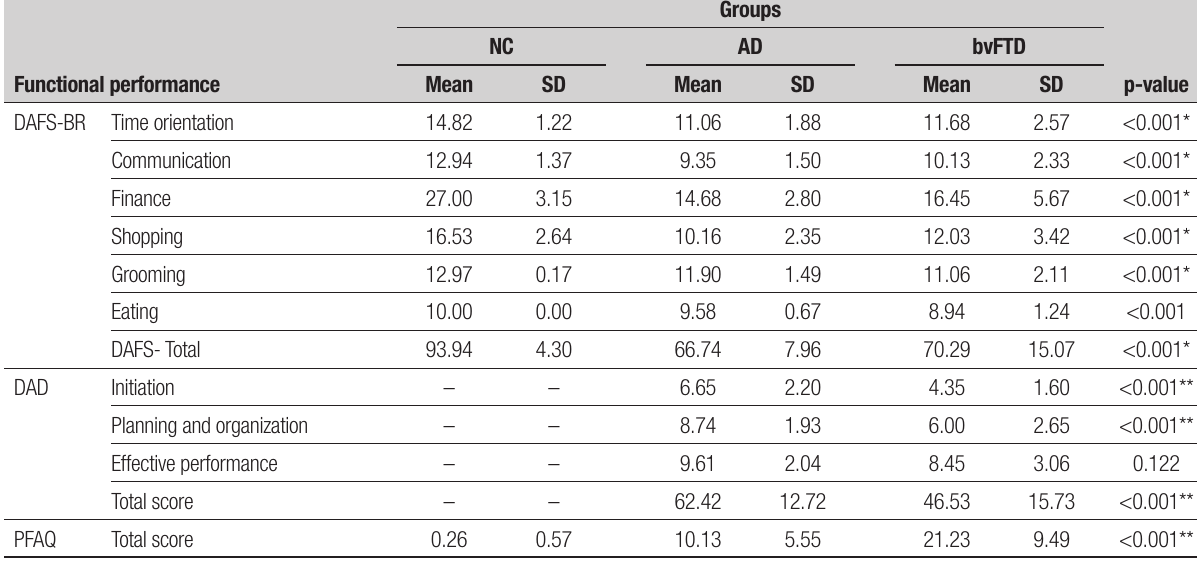
Table 4. Means and standard deviation for functional performance among the groups.